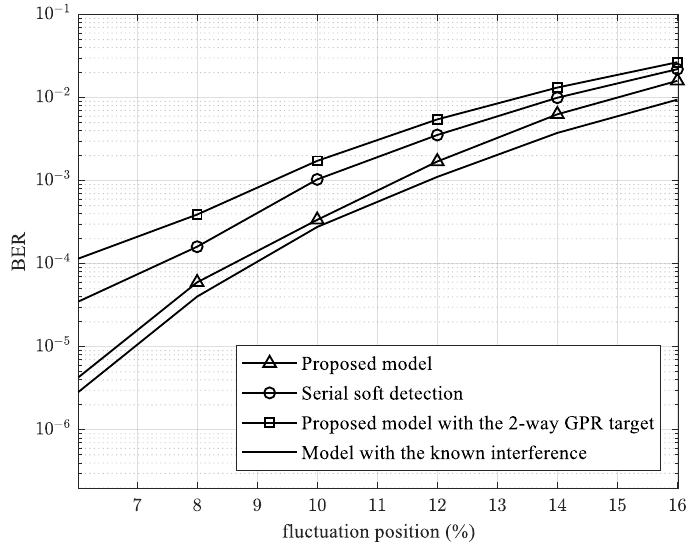
Figure 13. BER vs. position fluctuation from 6% to 16%.